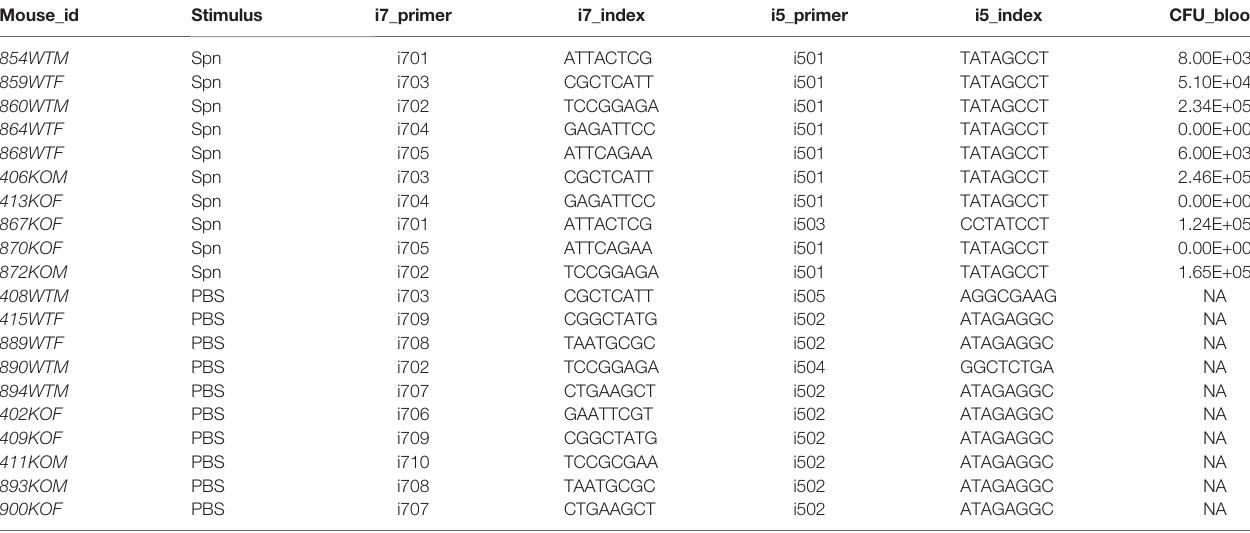
WT and KO mice were challenged with 2 x 10 5 total CFU TIGR4 or mock-infected with equivalent volumes of PBS. Lungs were harvested as described in methods 24 h p.i. CFU were quantitated from blood. Outliers are shown in red. For each group, WT (n = 5), KO (n = 5). NA, Not